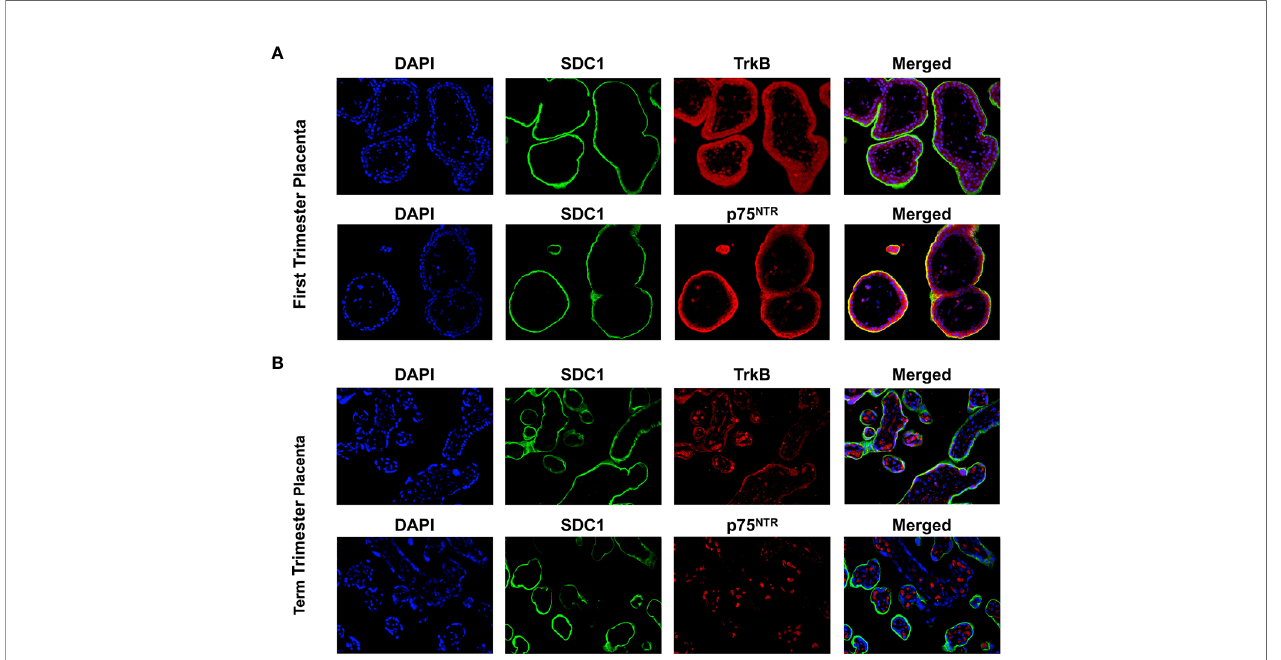
FIGURE 1 | Expression of BDNF receptors in human placental tissues. (A) Representative confocal immuno fl uorescence staining images of showing DAPI (blue) and SDC1 (a syncytiotrophoblast biomarker, green) along with TrkB (red) and p75 NTR (red) receptors in the fi rst trimester placenta. (B) Confocal immuno fl uorescence staining images showing DAPI, SDC1, TrkB, and p75 NTR in the term